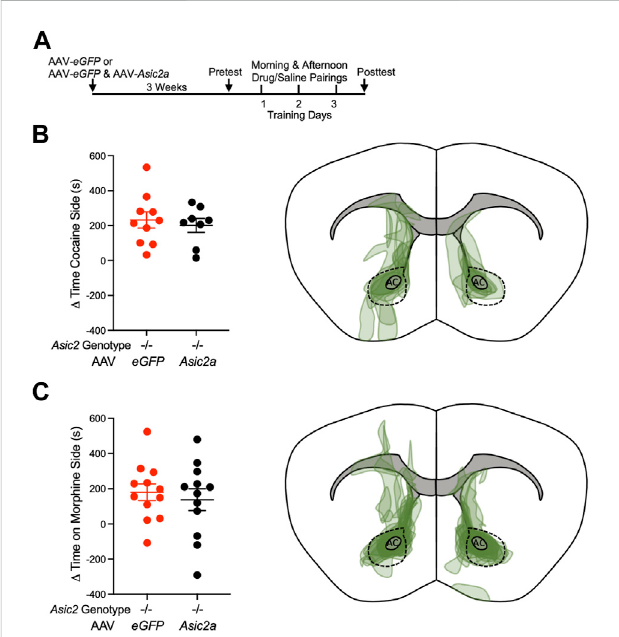
FIGURE 3 Expressing ASIC2A via AAV in NAcc of Asic2 − / − mice did not change CPP to cocaine or morphine. (A) Timeline of virus injection and post- operative recovery prior to CPP to cocaine or morphine. (B) Difference between posttest and pretest time on the cocaine-paired side revealed no effect of AAV- Asic2a in NAcc of Asic2 − / − mice [t (16) = 0.4853, p = 0.6340, Student ’ s t -test, n = 10 and 8 mice]. Targeting map of AAV- Asic2a virus in cocaine CPP animals. (C) Difference between posttest and pretest time on the morphine-paired side revealed no effect of AAV- Asic2a in NAcc of Asic2 − / − mice [t (22) = 0.5310, p = 0.6007,Student ’ s t -test, n =12mice].Targeting mapofAAV- Asic2a virus inmorphineCPPanimals.AC,anteriorcommissure;dottedlinesencircle